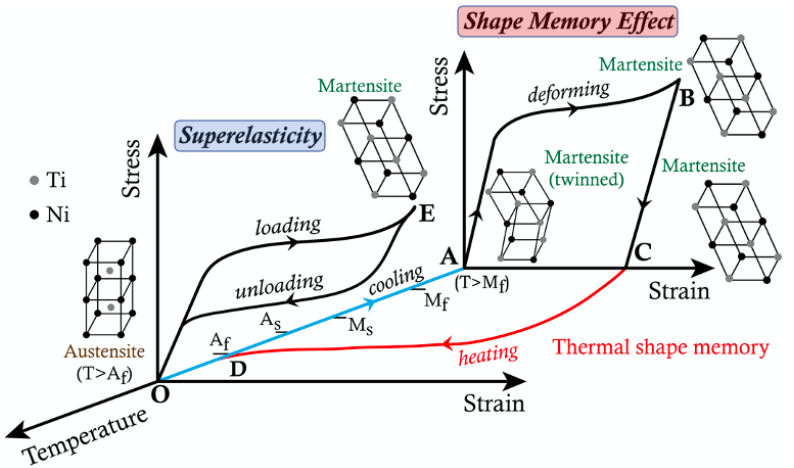
Figure 2. Stress-Strain-Temperature diagram of shape memory alloys showing Shape Memory Effect and Superelasticity or